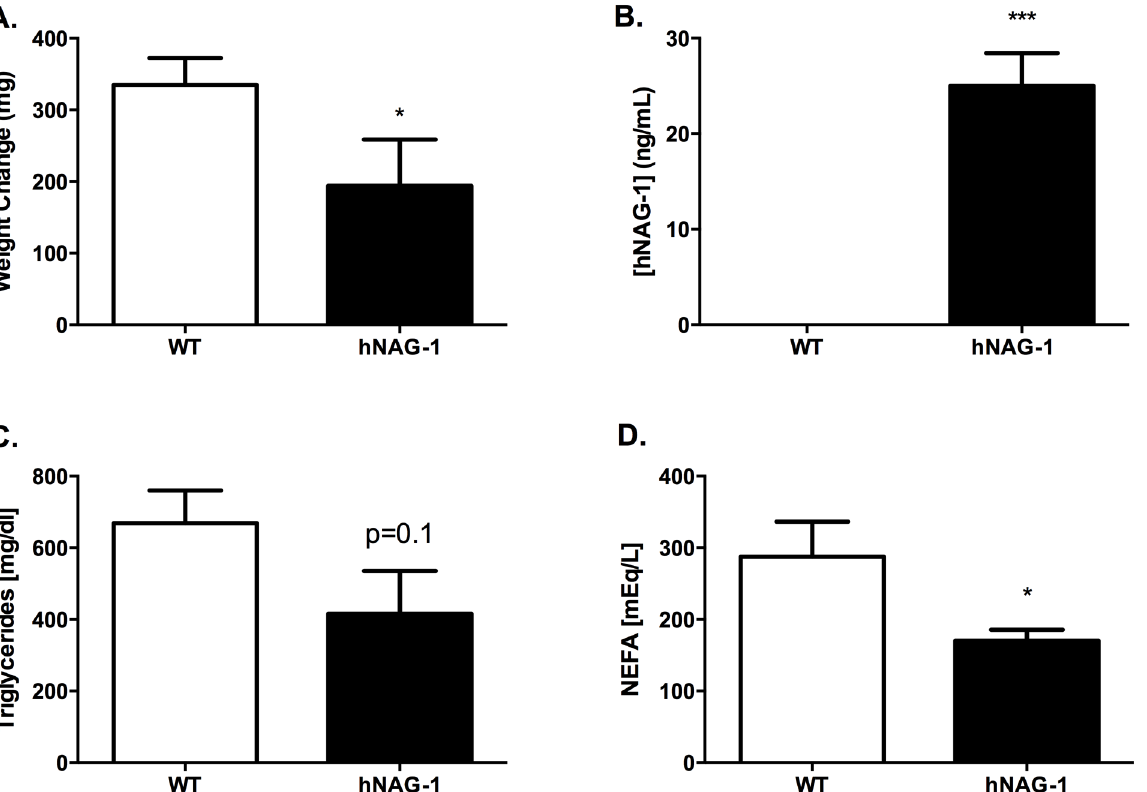
Fig 3. Reduced pup growth and altered milk composition in hNAG-1 dams. A.) On L2, Eight CD-1 pups were separated from their dam for 3 hours, weighed and placed back with the dam. Pups were allowed to nurse for 30 minutes and weighed again. Weight change due to increased milk intake was calculated. B-D.) Milk was isolated from WT (n = 4) and hNAG-1 (n = 6) mice on lactation day 2. ELISA to look at hNAG-1 concentrations present in milk (A), total triglycerides (B) or NEFA (C) in milk isolated from WT or hNAG-1 transgenic dams. Data shown is average +/- SEM. Mann-Whitney statistical test was used to compare hNAG-1 transgenic to WT dams. * , p < 0.05 and *** , p < 0.001.